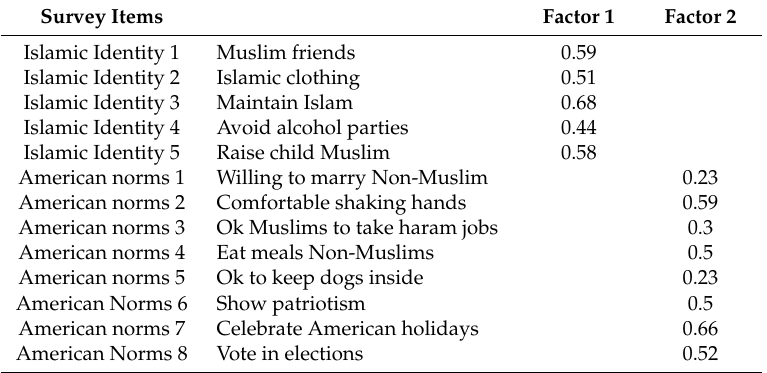
Table 1. EFA Results for the Muslim American Acculturation